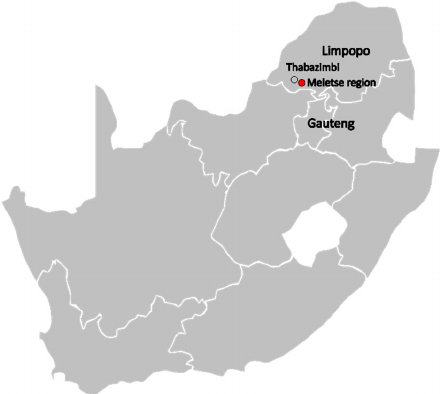
Figure 1. Map of the study site within South Africa, indicating the Meletse region compared to the nearest town (Thabazimbi) relative to the provinces of Limpopo and Gauteng.